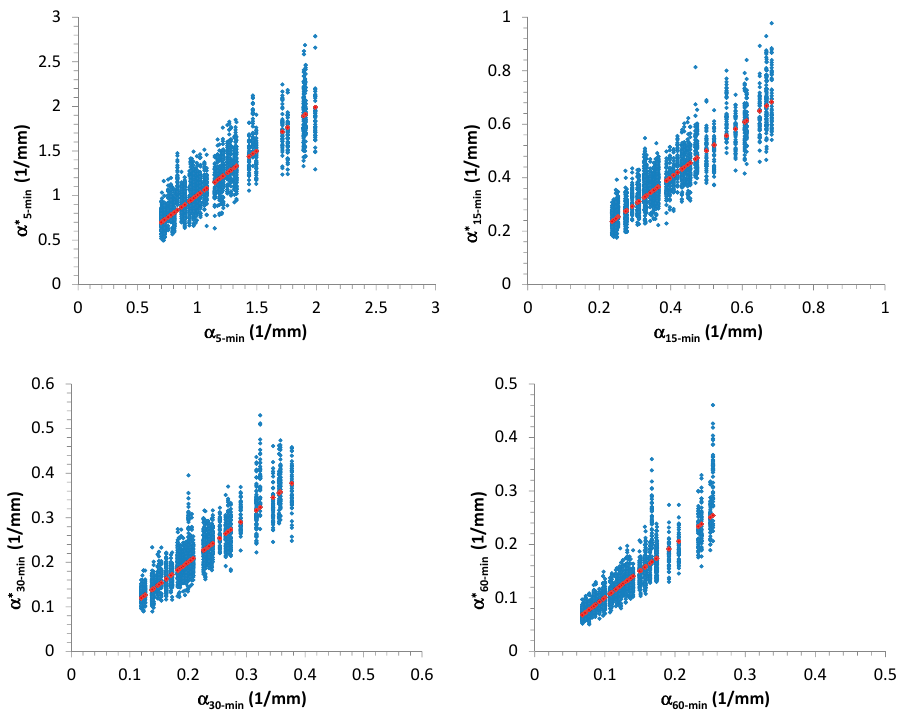
α (horizontal axis) and